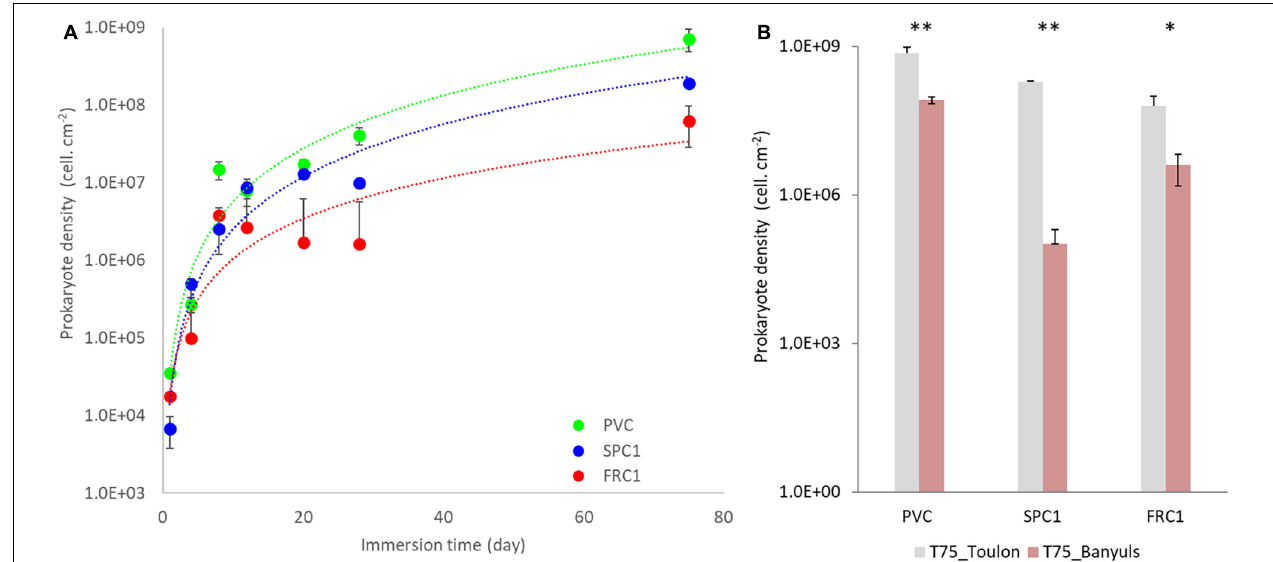
FIGURE 1 | Prokaryotic density colonizing PVC as well as two AF coatings (SPC1 and FRC1) from 1 to 75 days at Toulon bay (A) and after 75 days only at Banyuls bay (B) using Flow cytometry analyses. Statistical differences between sites were shown as follows: ∗∗ ( p < 0.01), ∗ ( p < 0.05). p < 0.05) at Toulon ( Figure 1 and Supplementary Figure 1